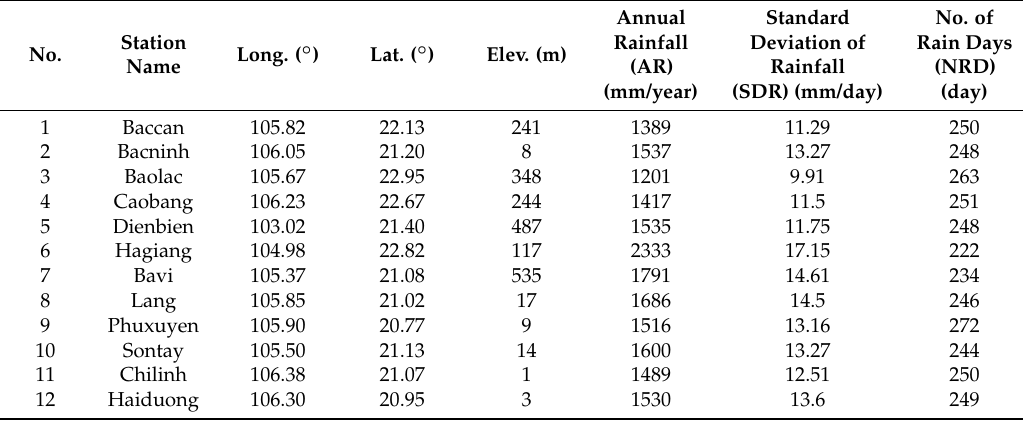
Table 1. Rainfall station descriptions for the ground observation stations over Red–Thai Binh River Basin (March 2000–December 2016).